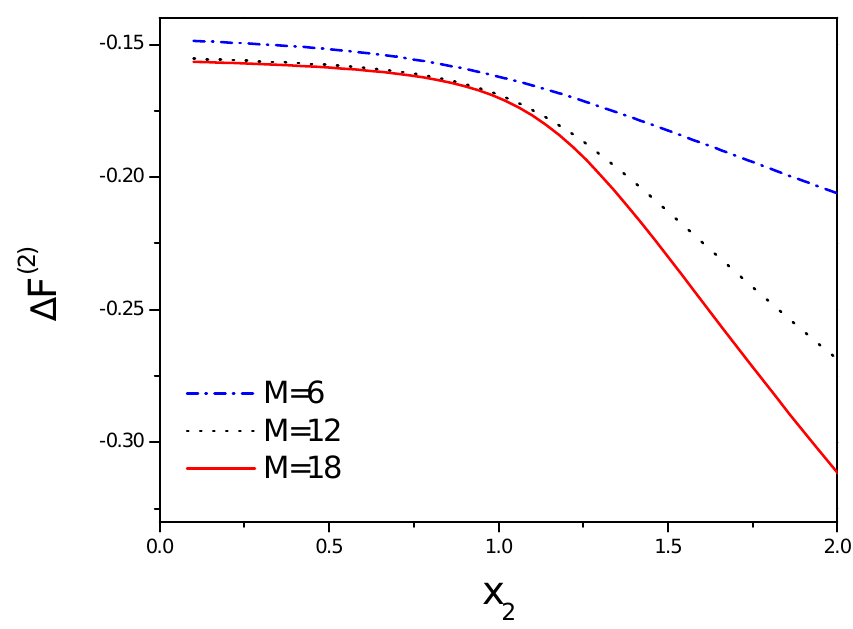
Figure 3. The free energy is dependent on the interaction between the first molecule and the second molecule. x 2 = g 2 / λ 2 , where the free energy for each bond is − k B Tlng 2 that illustrates the loss of 1 conformational entropy from both chains, and λ 1 indicates the contribution form the peptide tails not participating in the hydrogen bonds. ∆ F ( 2 ) = F ( 2 ) − 2 F ( 1 ) accounts for the free energy difference from both chains. The free energy will be decreased when the number of the hydrogen bond increases from 6 to